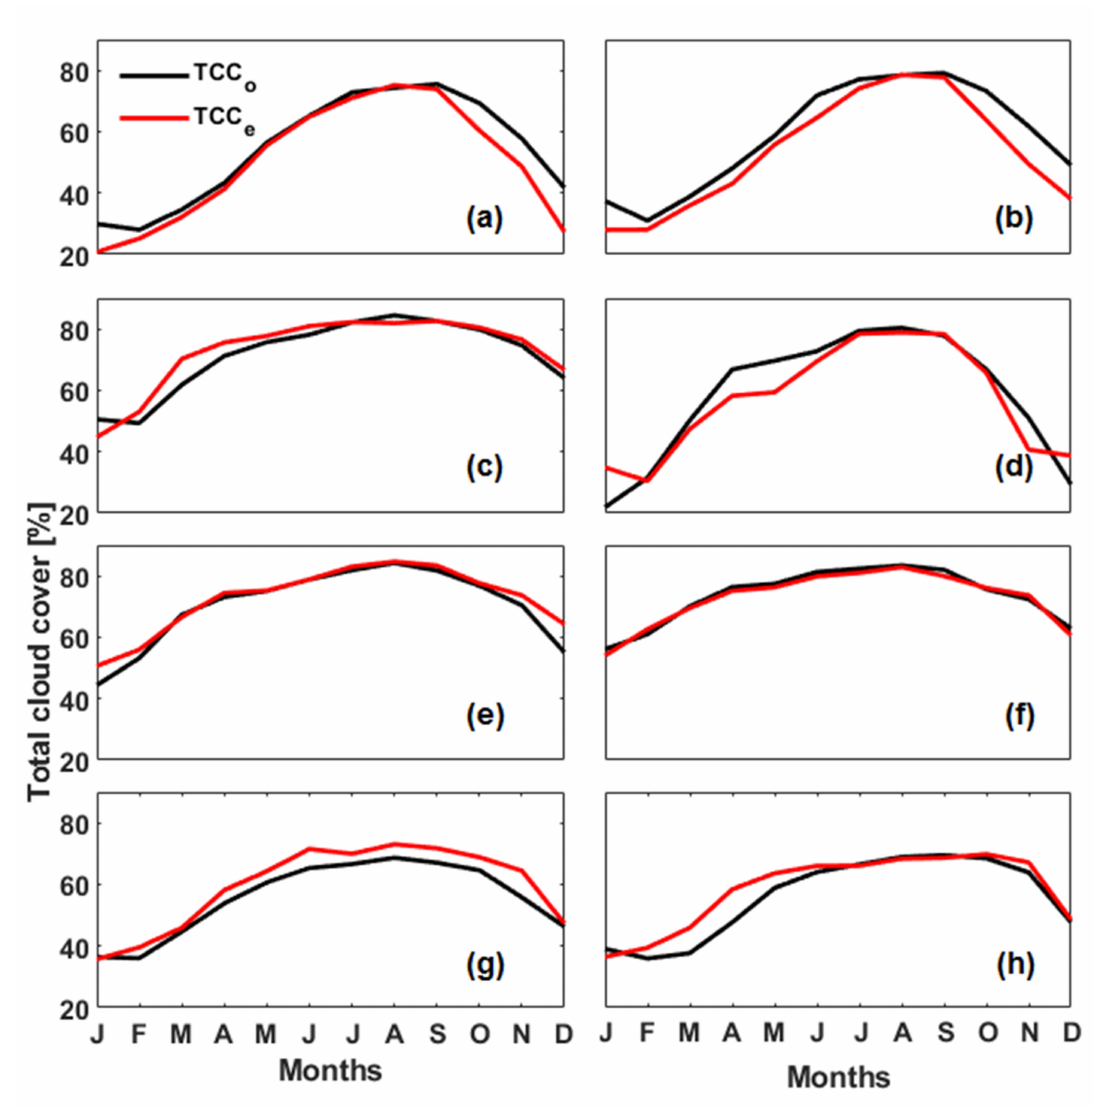
Figure 4. Time series comparing sunshine-duration-based estimated total cloud cover (TCC e ) and station-observed total cloud cover (TCC o ) for selected stations at ( a ) Wa and ( b ) Yendi in the savannah region, ( c ) Sunyani and ( d ) Kete-Krachi in the transitional region, ( e ) Kumasi and ( f ) Akim Oda in the forest region, and ( g ) Takoradi and ( h ) Accra in the coastal